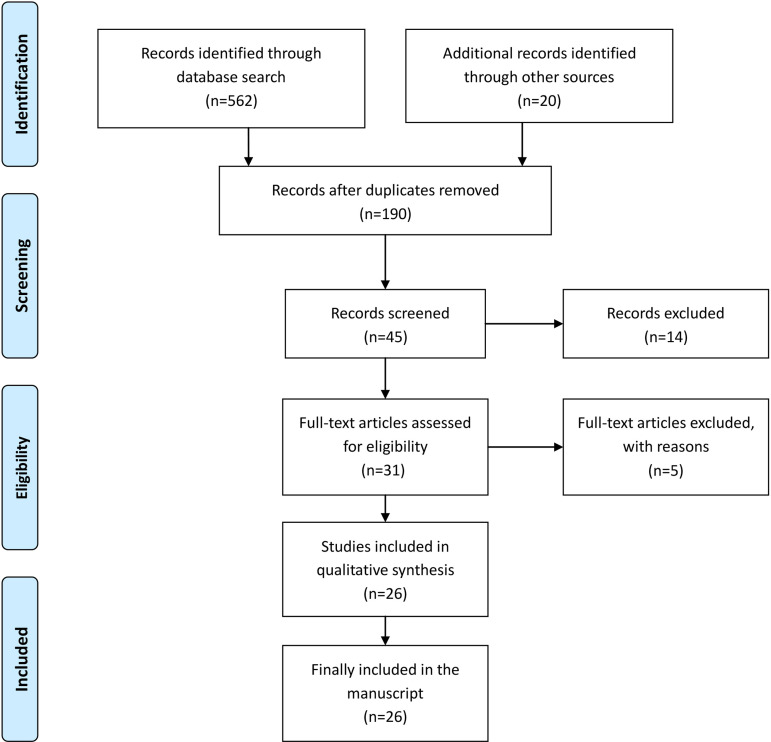
The study flow diagram.